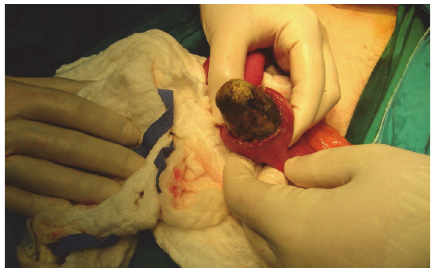
Figure 3: Large stone extracted from within the jejunal lumen by enterotomy with subsequent primary